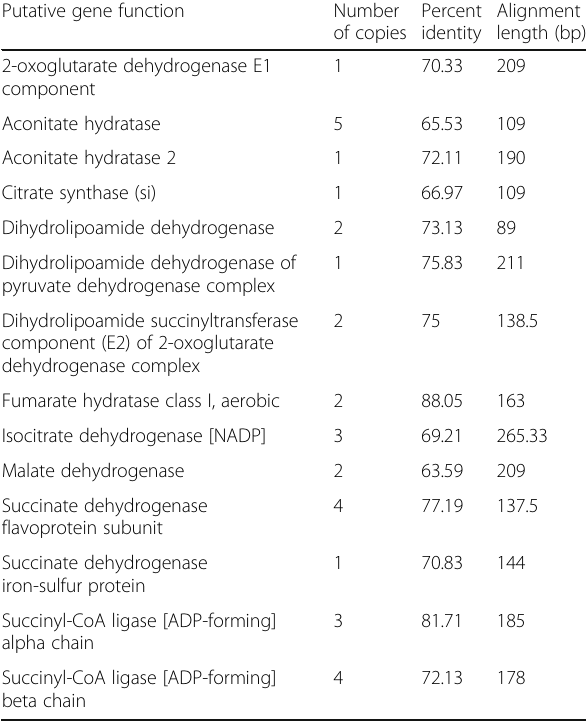
Table 3 Putative gene functions involved in a complete TCA cycle identified by MG-RAST Putative gene function Number